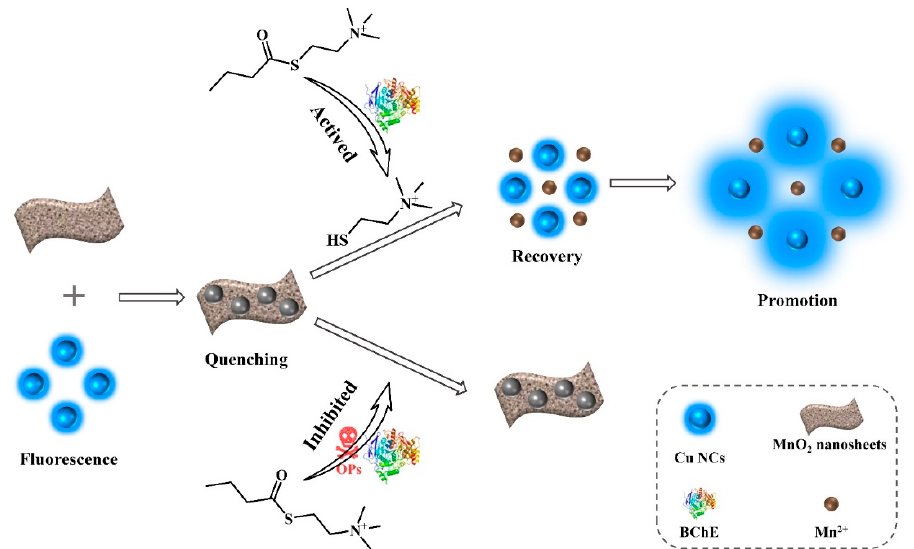
Figure 1. Schematic illustration for the detection of OPs based on the platform of Cu NCs/MnO 2 nanosheets.